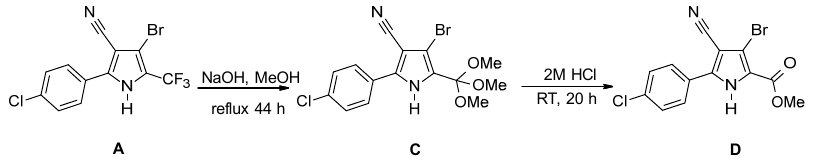
Table 1. Average leach rates of Econea ® from synthetic mixtures and a commercial coating. Sampling Regime from Coating